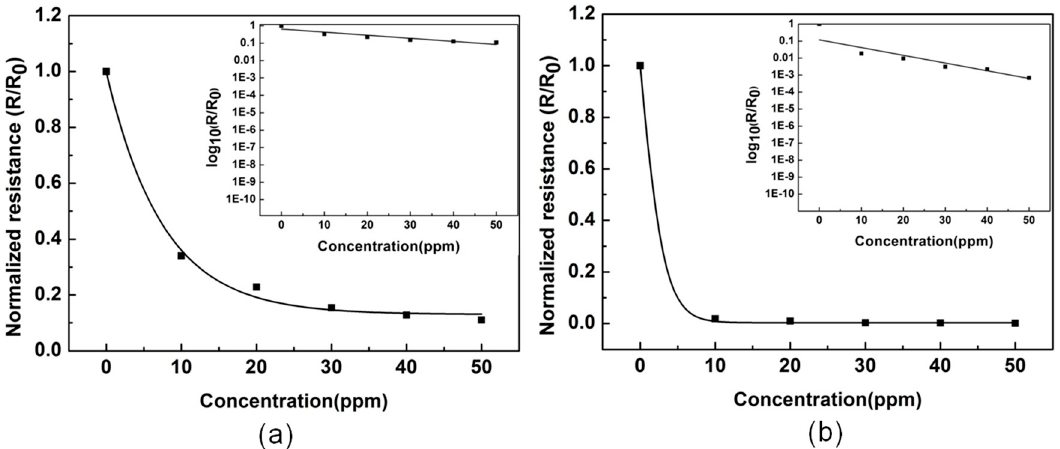
Figure 6. Resistance changes of ( a ) conventional electrospun nanofiber film with an average fiber diameter of 263 nm and ( b ) ultrafine nanofiber film with an average fiber diameter of 68 nm upon exposure to different concentrations of ammonia. R/R 0 is the resistance (R) normalized to the initial resistance (R 0 ) prior to gas exposure.